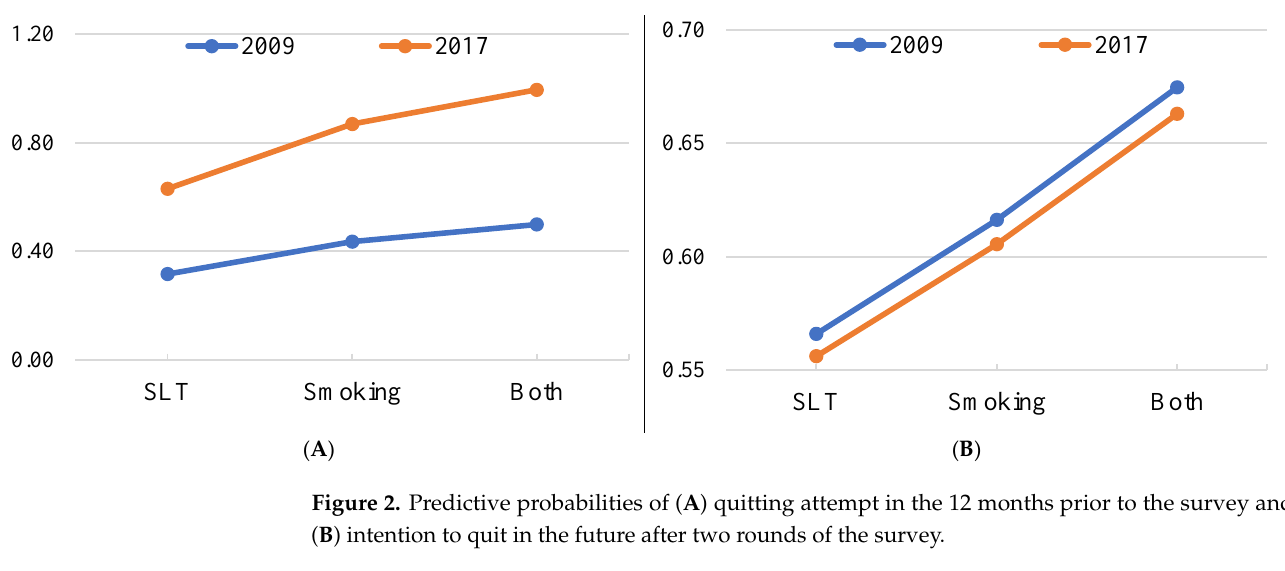
Table 3. Multivariable Poisson regression (with robust variance) examining the associations between intention to quit in the future and quitting attempts during the 12 months before the